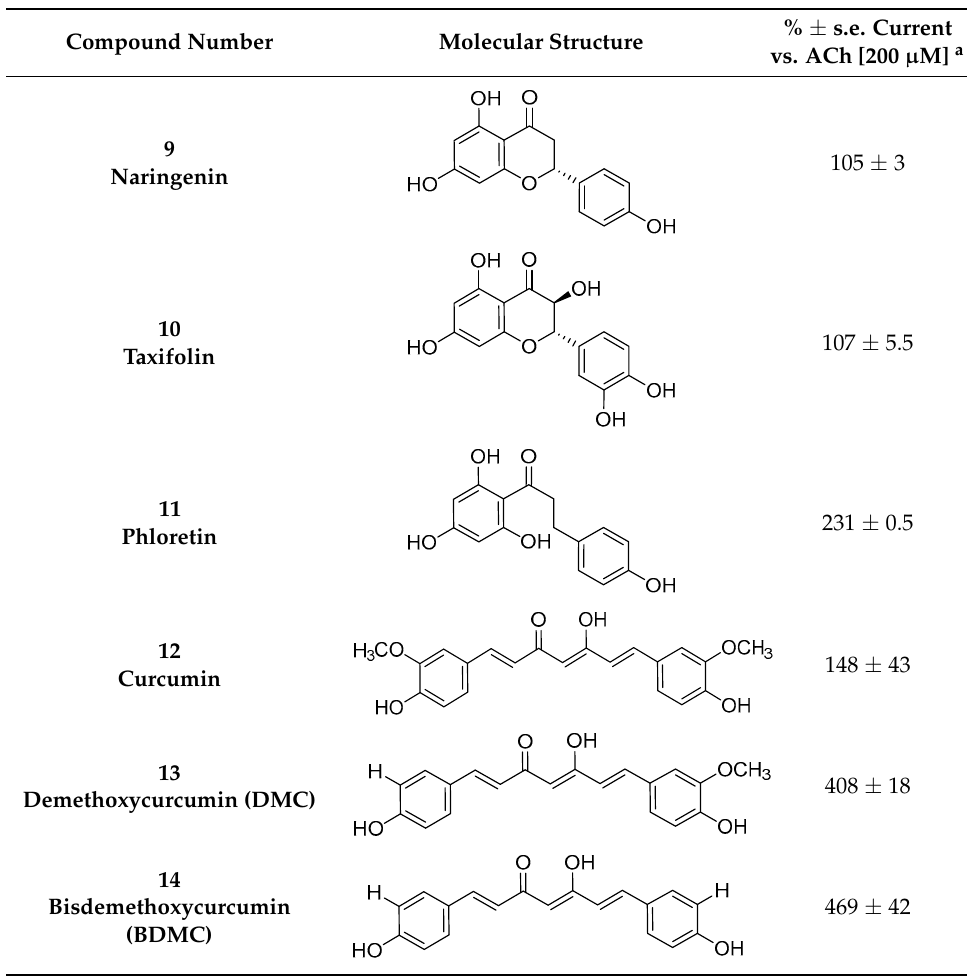
a Compounds were tested at a unique dose of 10 µM, which was co-applied with 200 µM ACh. Responses were recorded at − 80 mV and normalized with respect to that shown by only ACh (200 µM). Data are taken from 6–10 oocytes from at least 2 donors.